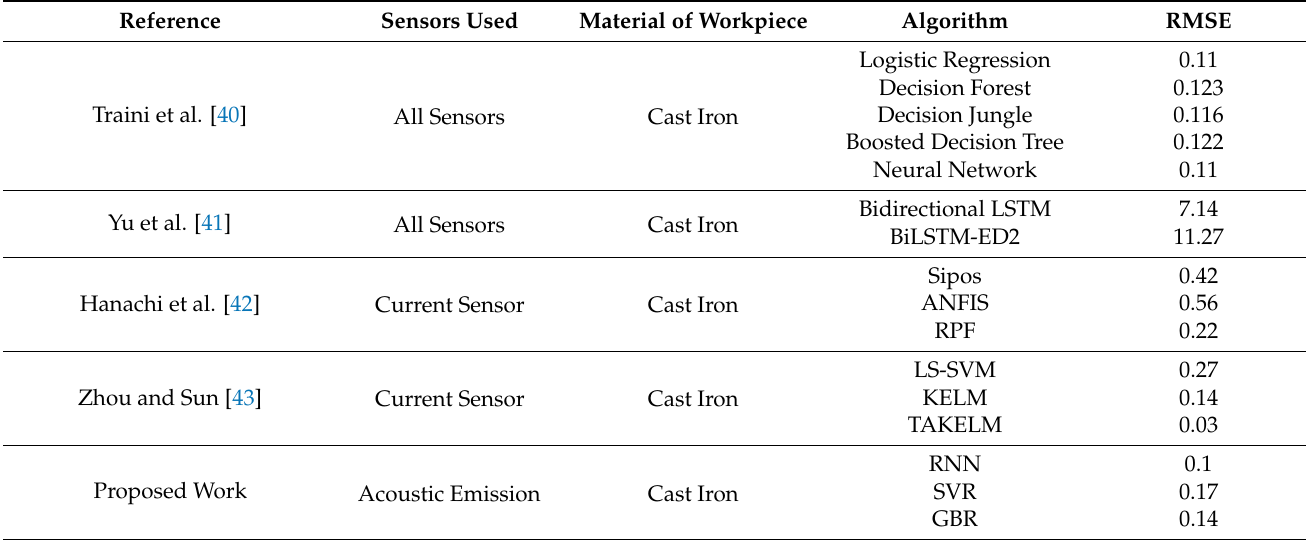
Table 6. Comparative study with the published